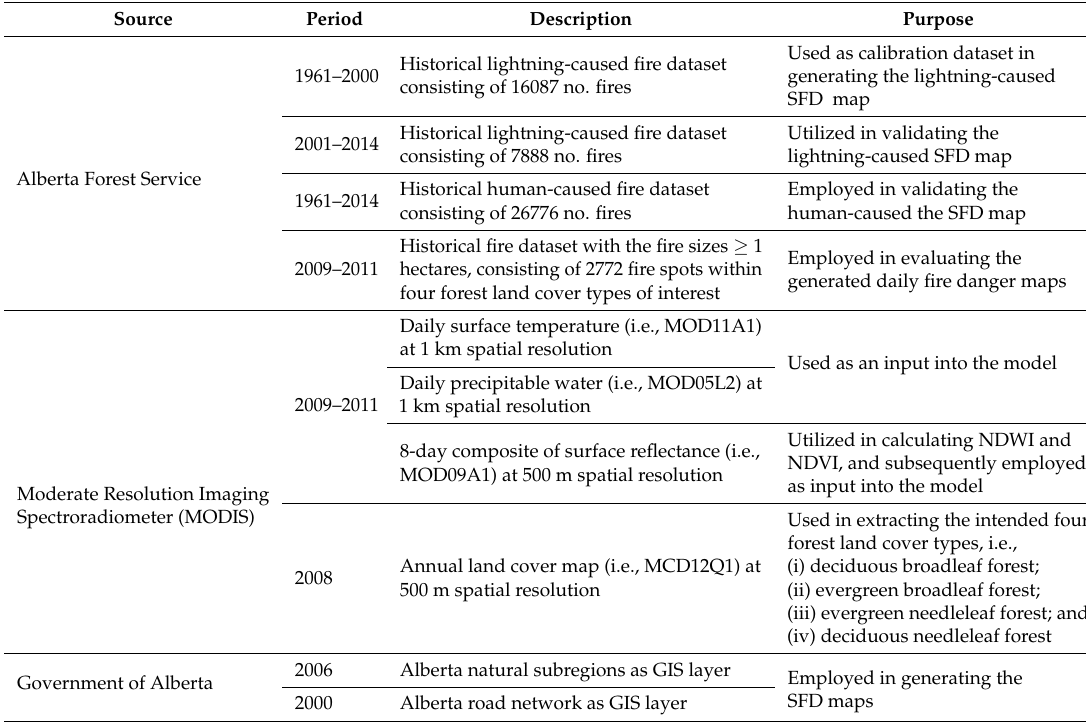
Figure 1. Map illustrating the location of the study area, and fire frequency (percentage of lightning- and human-caused in parenthesis, respectively) in all 21 natural subregions during the period of 1961–2014 in Alberta, Canada. The asterisk marks denote the subregions where we observed at least one fire occurrence during the period of interest. Table 1. Description of the employed datasets in the scope of this study.